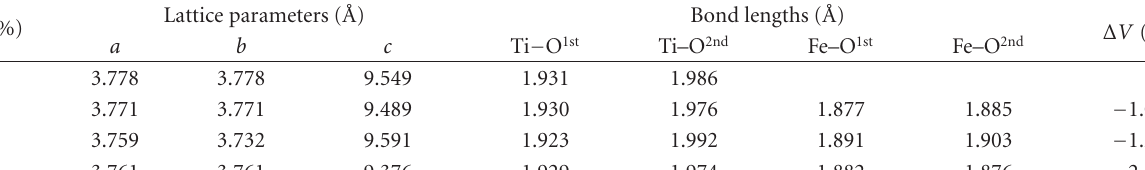
Table 1: Optimized lattice parameters, average bond lengths, and volume di ff erence ( Δ V ) of TiO 2 doped with various concentrations of Fe. Fe (at.%)